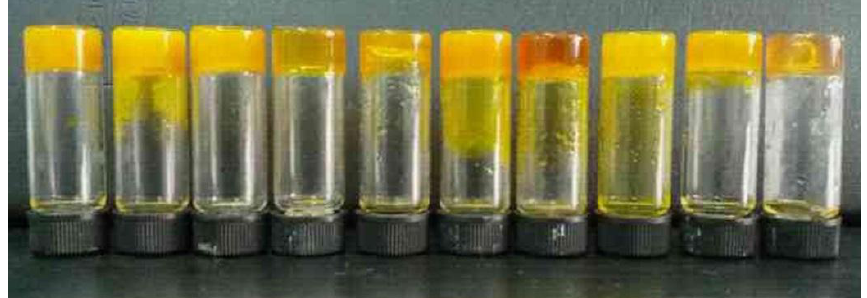
Figure 1. Photographs of organogels of CH-PY in different solvents: n-butanol, n-pentanol, isopentanol, isooctanol, cyclopentanone, cyclohexanone, nitrobenzene, n-butyl acrylate, THF, and DMF (from left to right).